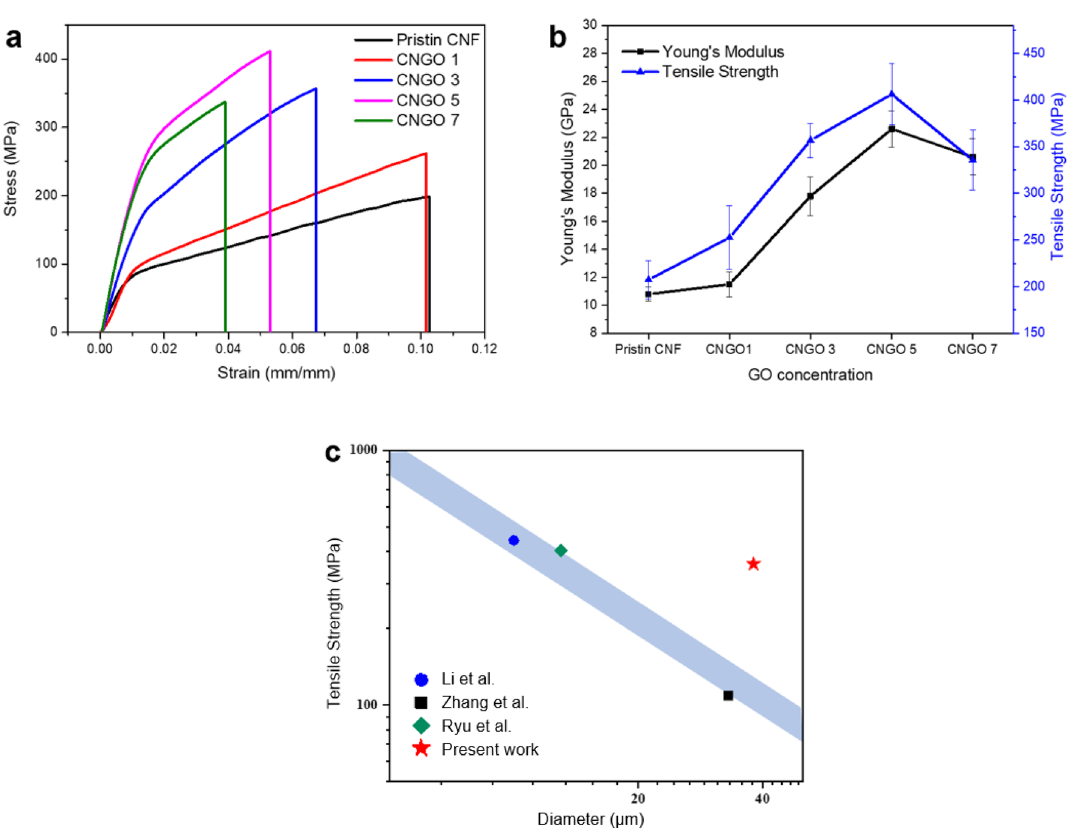
Figure 7. Mechanical properties of CNGO hybrid filaments: ( a ) stress–strain curves, ( b ) variations of Young’s modulus and tensile strength with the GO concentration, ( c ) comparison of tensile strength with other reports in terms of filament